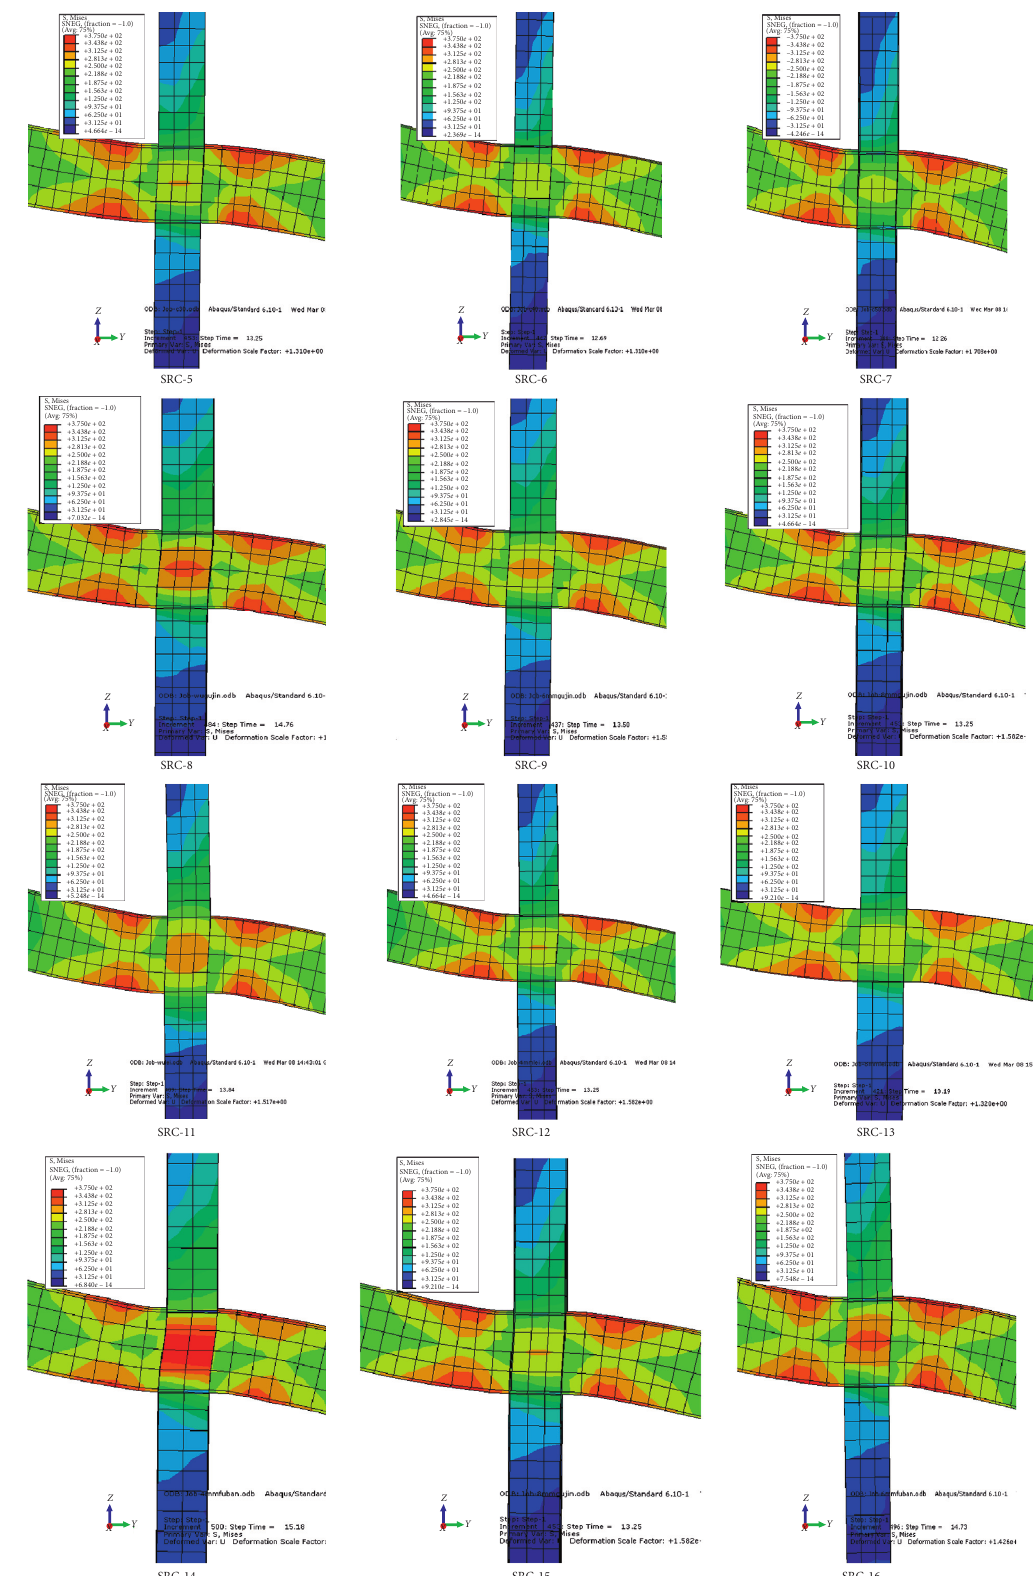
Figure 21: Stress distribution of specimen in ultimate